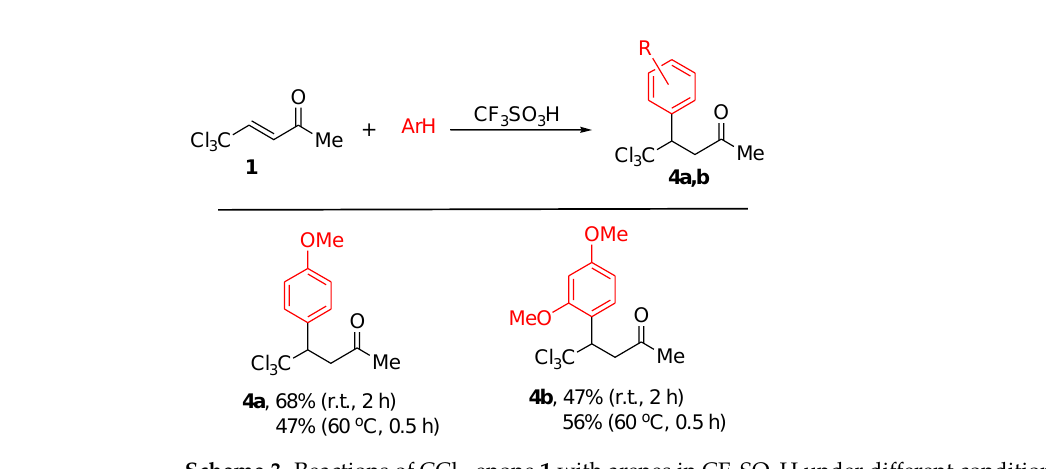
3 -enone 1 in Brønsted